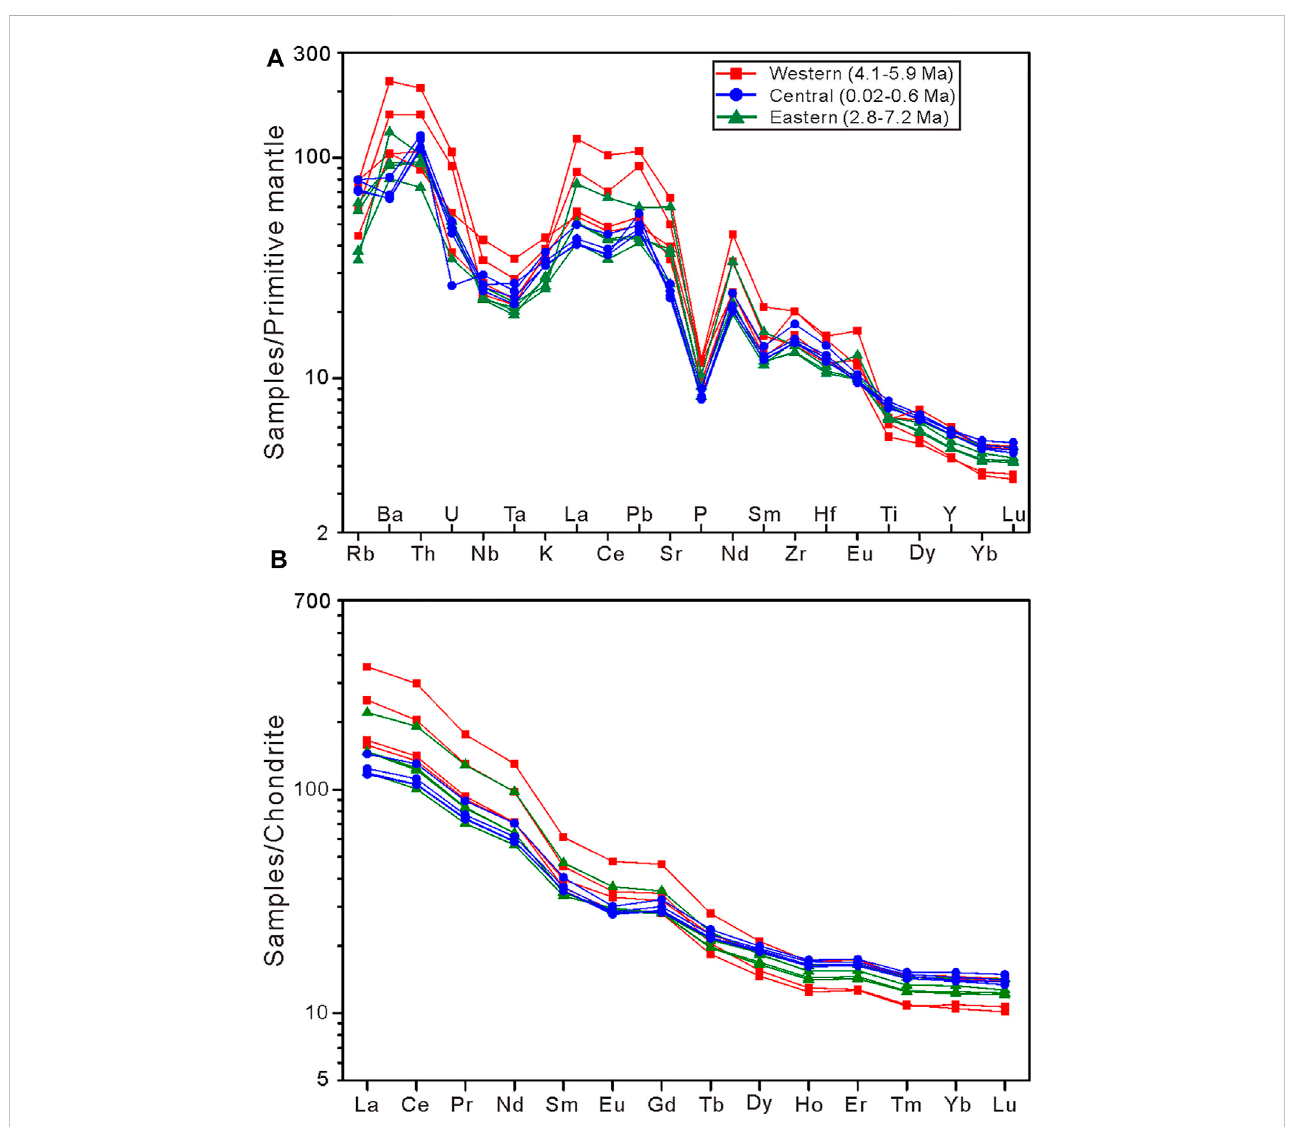
FIGURE 5 (A) Diagram of primitive mantle-normalized trace elements; (B) diagram of chondrite-normalized rare Earth elements. The normalization factors are from Sun and McDonough